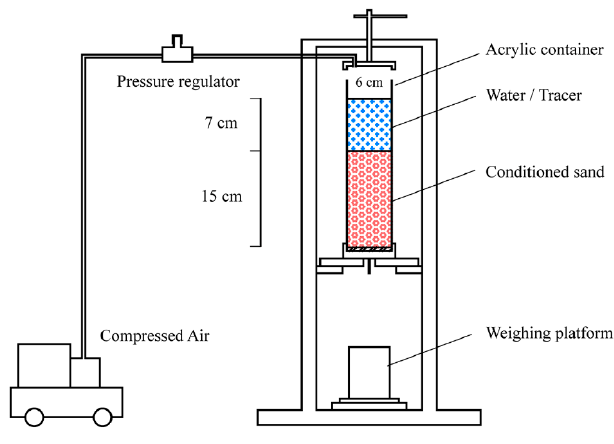
Figure 3. Permeability test device.